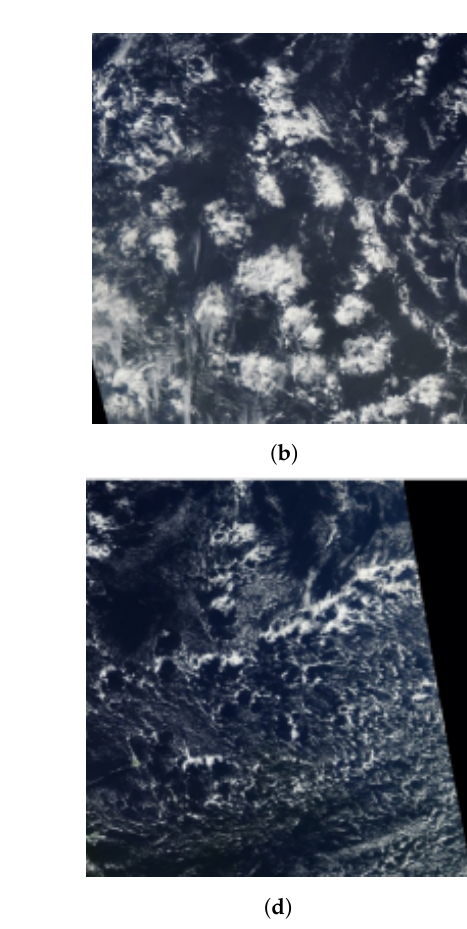
Figure 1. Samples of the four cloud categories: Sugar, Flower, Fish, and Gravel. ( a ) Sugar; ( b ) Flower; ( c ) Fish; ( d )